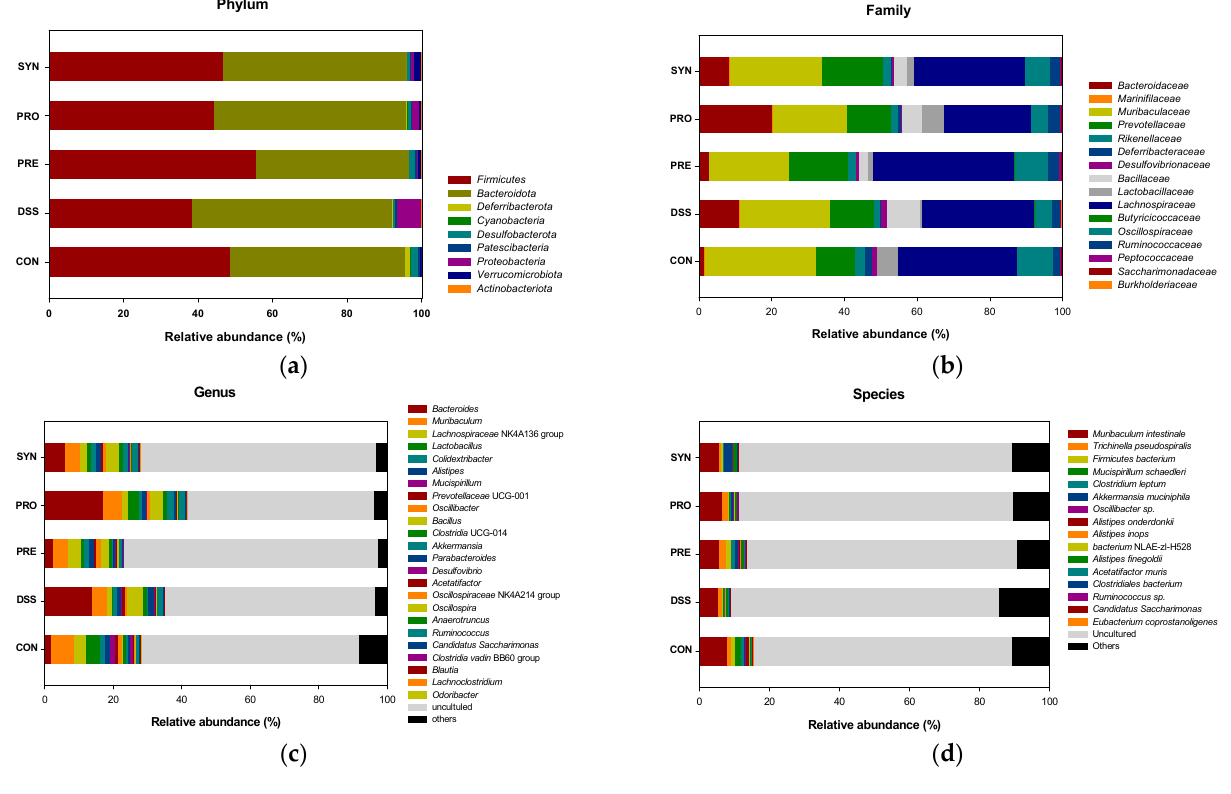
Figure 4. Effects of PRE, PRO, and SYN on gut microbiome composition of DSS-induced colitis mice. Relative abundance (%) at the phylum ( a ), family ( b ), genus ( c ), and species ( d ) level of each group. The results were presented as the mean ± SD ( n = 3). Data were statistically considered at p < 0.05, and different lowercase letters indicate significant differences between groups. Table 1. Effect of PRE, PRO, and SYN on gut microbiome composition relative abundance of DSS- induced colitis mice.